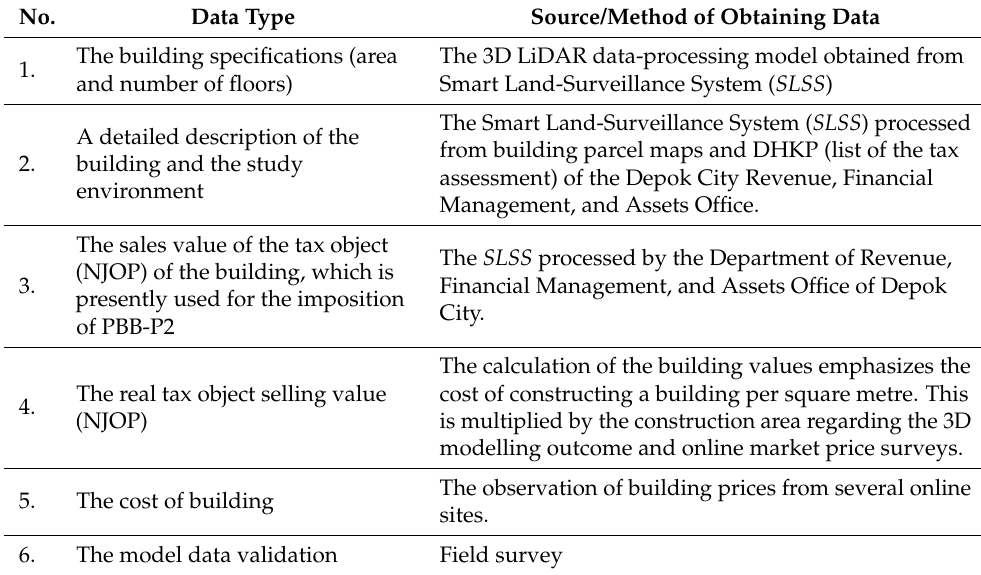
Table 1. Required